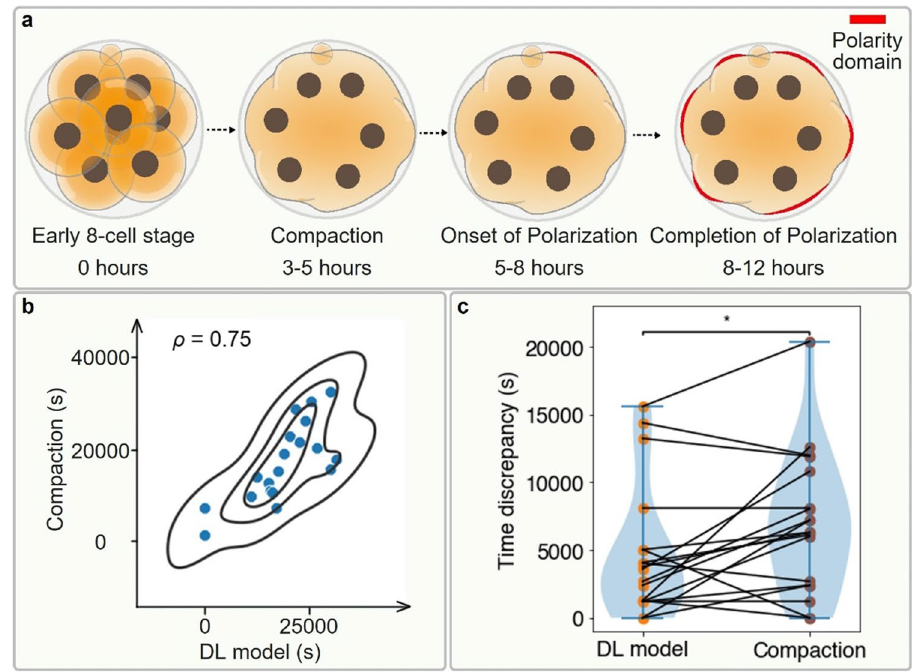
Figure 5. Comparative analysis of the ensemble deep learning model prediction and the compaction-based prediction for polarization. ( a ) Chronological order of compaction and polarization events during the 8-cell stage for a normal mouse embryo. ( b ) Correlation analysis between time points of DL model polarity prediction and compaction. The x and y coordinate are the predicted polarity onset time index of testing embryos (marked in blue solid balls) by the ensemble DL model and the annotated compaction time index, respectively. Their pairwise relationship shows a Pearson correlation coefficient ( ρ ) of 0.75. ( c ) Violin plot to visualize the time discrepancy between the annotated and the predicted polarity onset time index on 19 testing embryos by ensemble DL model and compaction proxy, overlaid with a slopegraph showing each testing embryo prediction time discrepancy in pair. From the kernel density estimate (blue shade) of violin plot and the connection line trends of slopegraph, we can tell that the prediction time discrepancy of DL model is significantly lower than the one of compaction proxy. The p -value is specified in the figure for * p < 0.05, ** p < 0.01, *** p < 0.001, **** p < 0.0001, NS not significant, two-sided Wilcoxon matched-pairs signed-rank